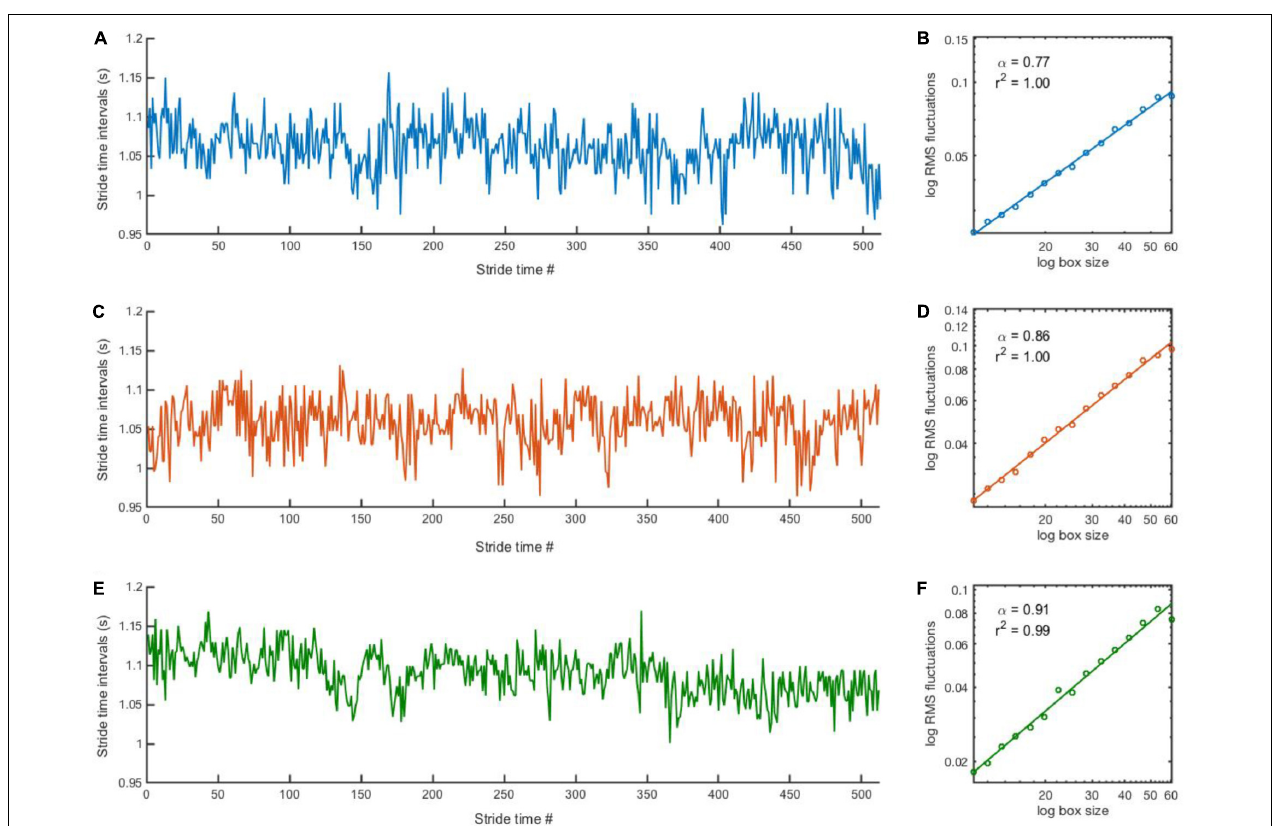
FIGURE 1 | Stride time series and corresponding DFA plot. Representative examples of stride time series (left) and corresponding DFA plot (right) from a participant in the PD group in the “15 min” (A,B) , “3 min” (C,D) and “30 s” (E,F) blocks. Note that it is impossible to distinguish where the stitching occurred for the “3 min” (C) and “30 s” (E) time